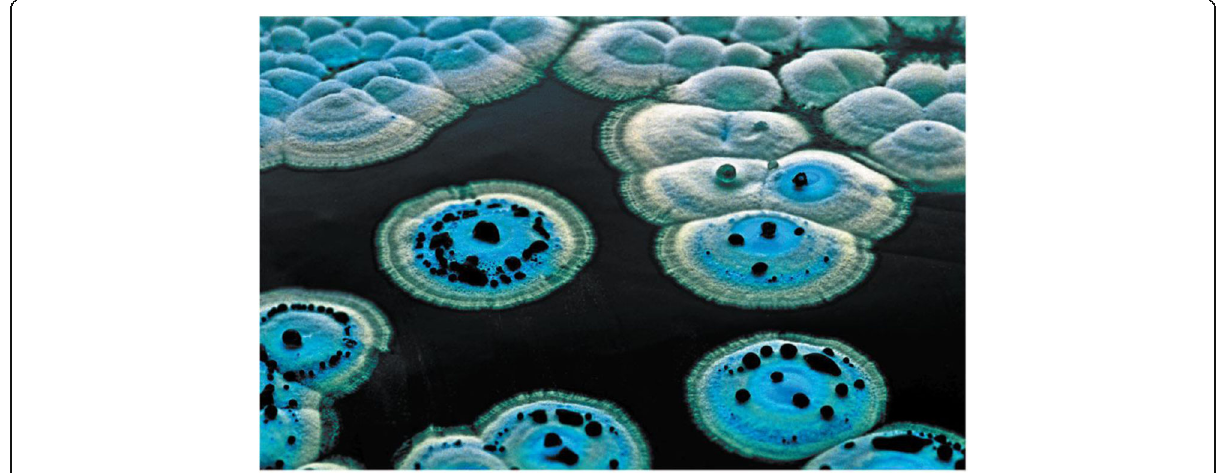
Fig. 6 A panoramic view of Streptomyces coelicolor including the blue antibiotic actinorhodin is excreted into the medium and into aqueous droplets on the hydrophobic surface of the colony